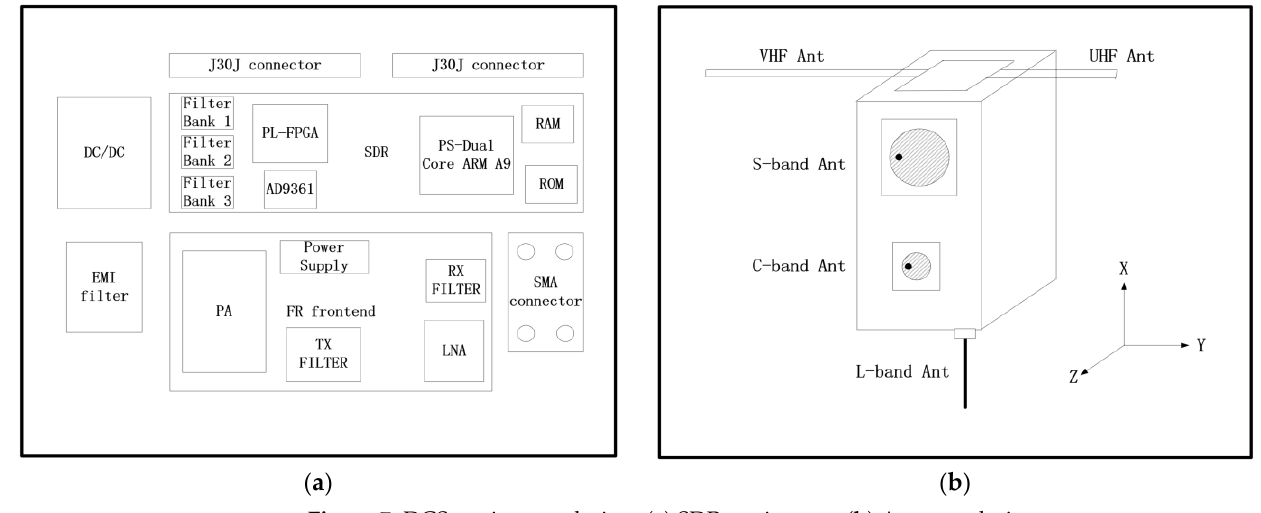
Figure 7. DCS equipment design: ( a ) SDR equipment; ( b ) Antenna design.